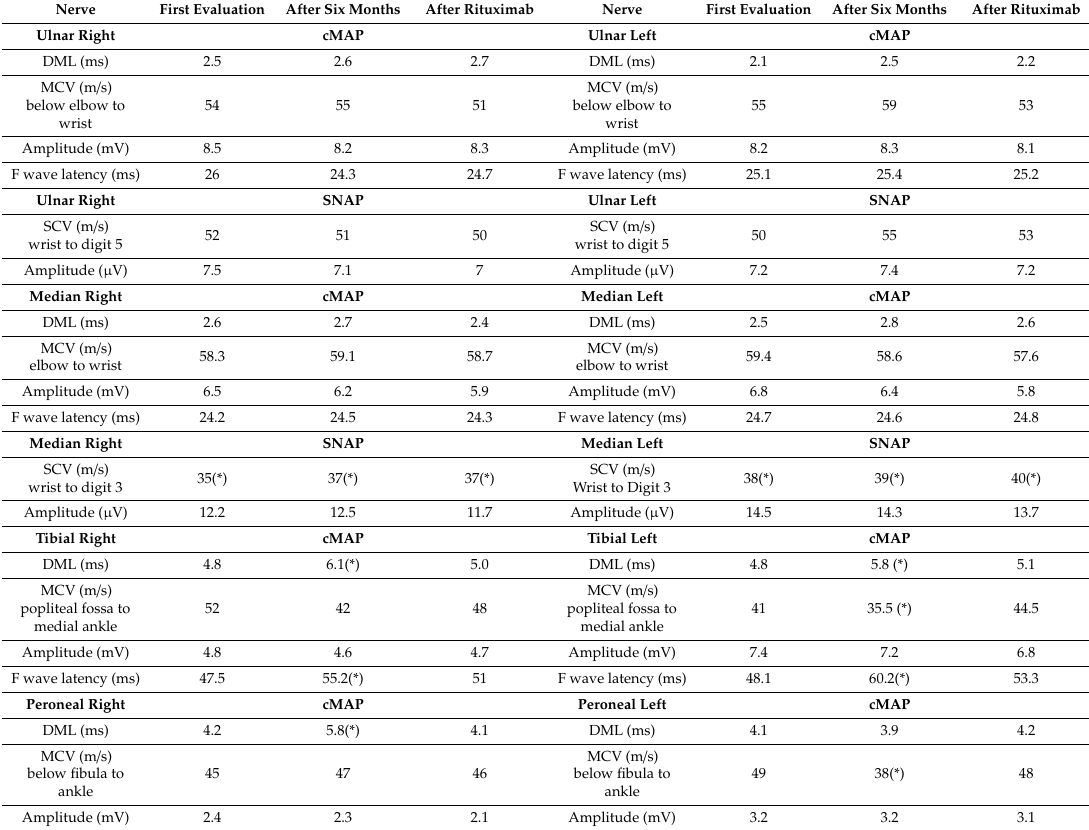
Table 1. Nerve conduction